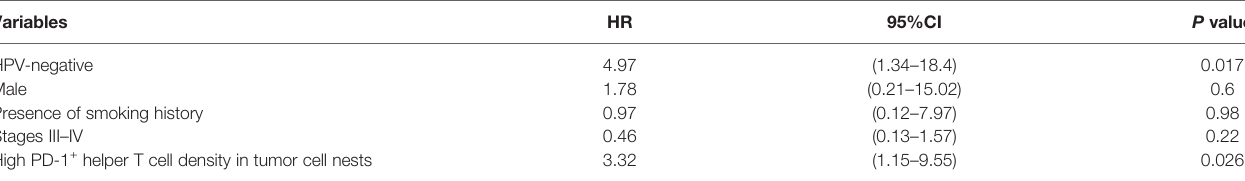
TABLE 1 | Variables associated with overall survival: Cox proportional hazards model (Validation cohort, N = 51).